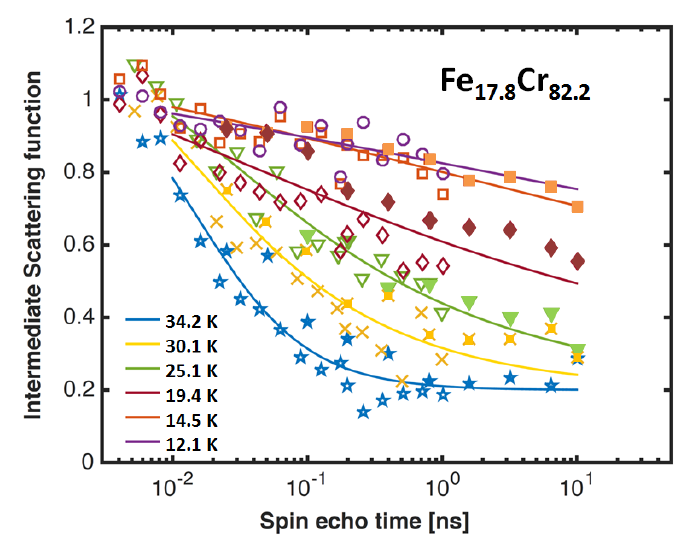
Figure 3. Intermediate scattering function as measured by neutron (resonance) spin echo at RESEDA (open symbols) and at J-NSE (filled symbols) for q (cid:39) 0.06 Å − 1 . The solid lines show the restricted